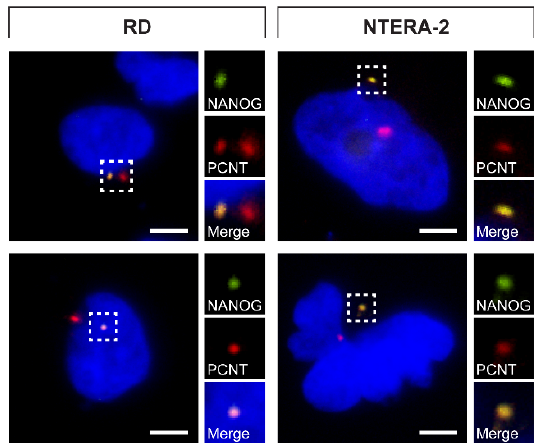
Figure 5. NANOG-GFP colocalization with centrosomes. NANOG-GFP (green) was detected in colocalization with the centrosomes stained by anti-pericentrin antibody (PCNT; red). The nuclei were counterstained with Hoechst 33342 (blue). For each image, a region of interest is indicated by the dashed box, and the respective close-ups are provided on the right. Scale bars, 5 µ m.